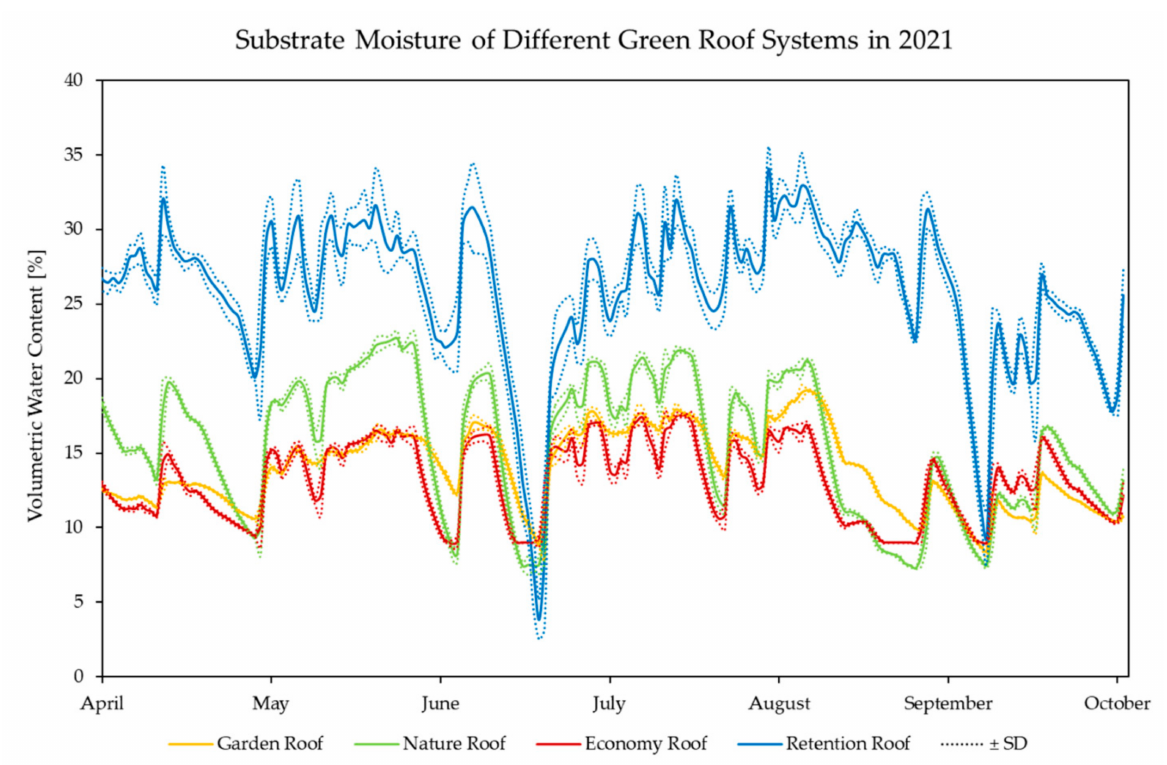
Figure 5. Daily averages ± standard deviation (SD) of the soil moisture of the four different green roofs from April to October 2021.